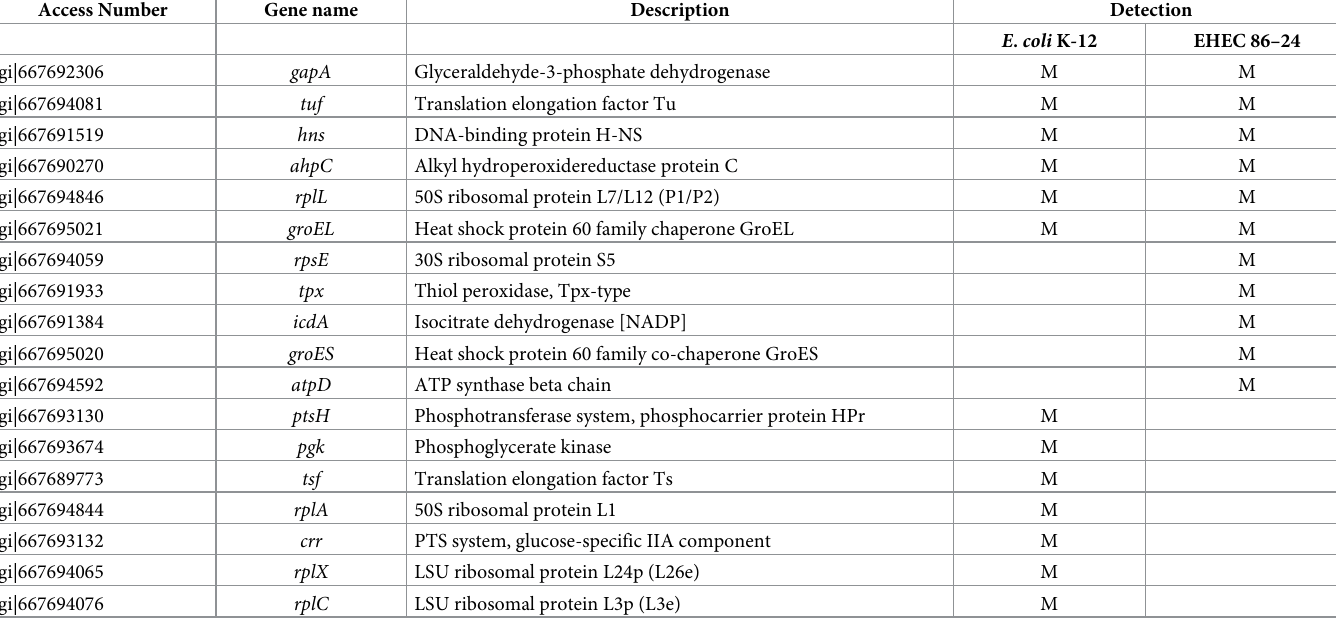
Table 2. List of the most abundant proteins detected in E . coli K-12 and EHEC